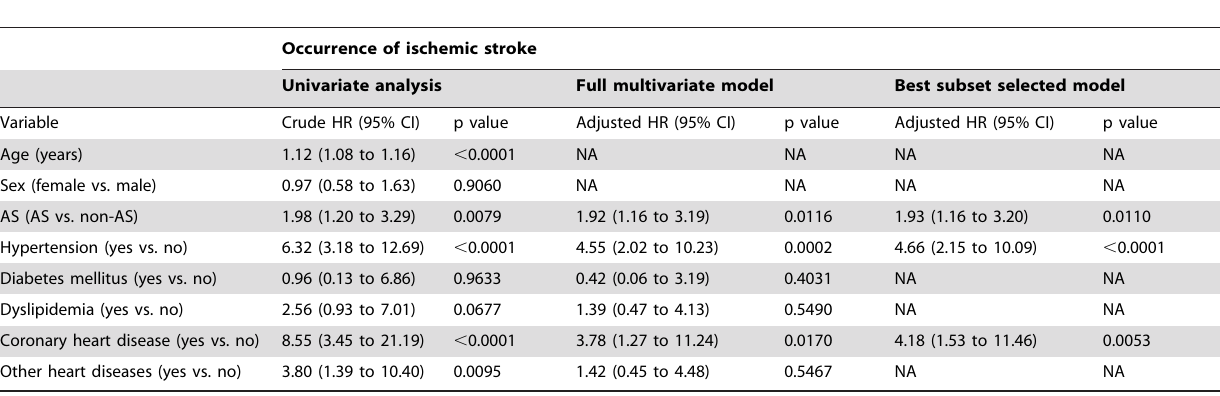
Table 2. Crude and adjusted hazard ratio (HR) for the occurrence of ischemic stroke during the two-year follow-up period in the AS and non-AS